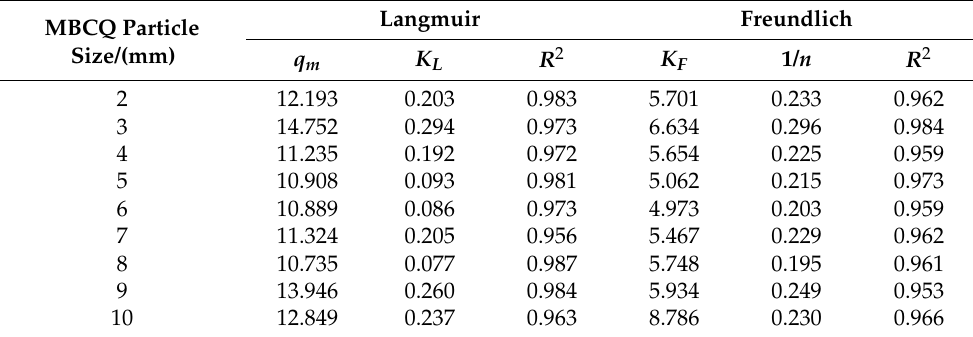
Table 2. Estimated parameters of the traditional adsorption isotherm models. Langmuir Freundlich MBCQ Particle Size/(mm) q